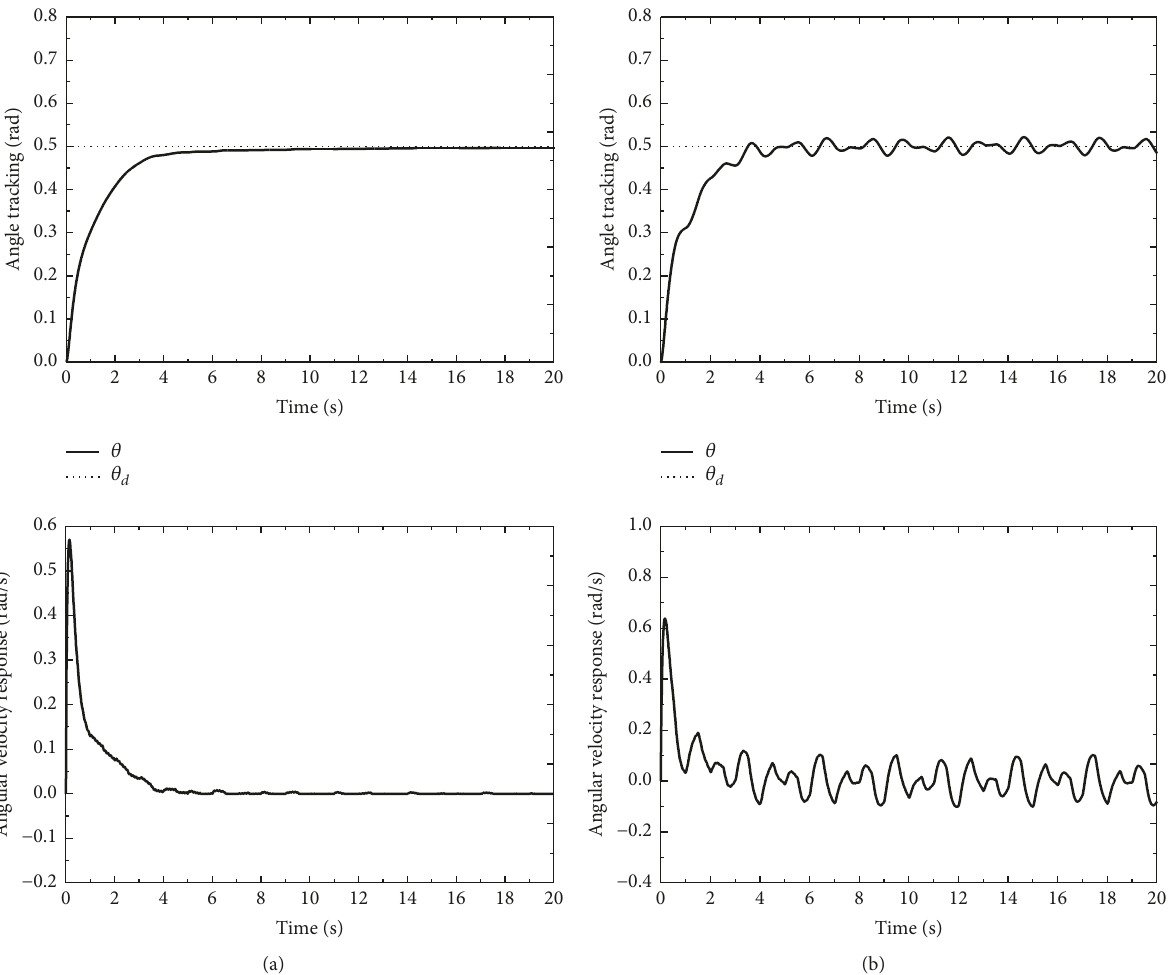
Figure 2: Responses in motor angle and angular velocity for (a) the boundary control scheme with the high order observer and (b) the control scheme employing the constant disturbance